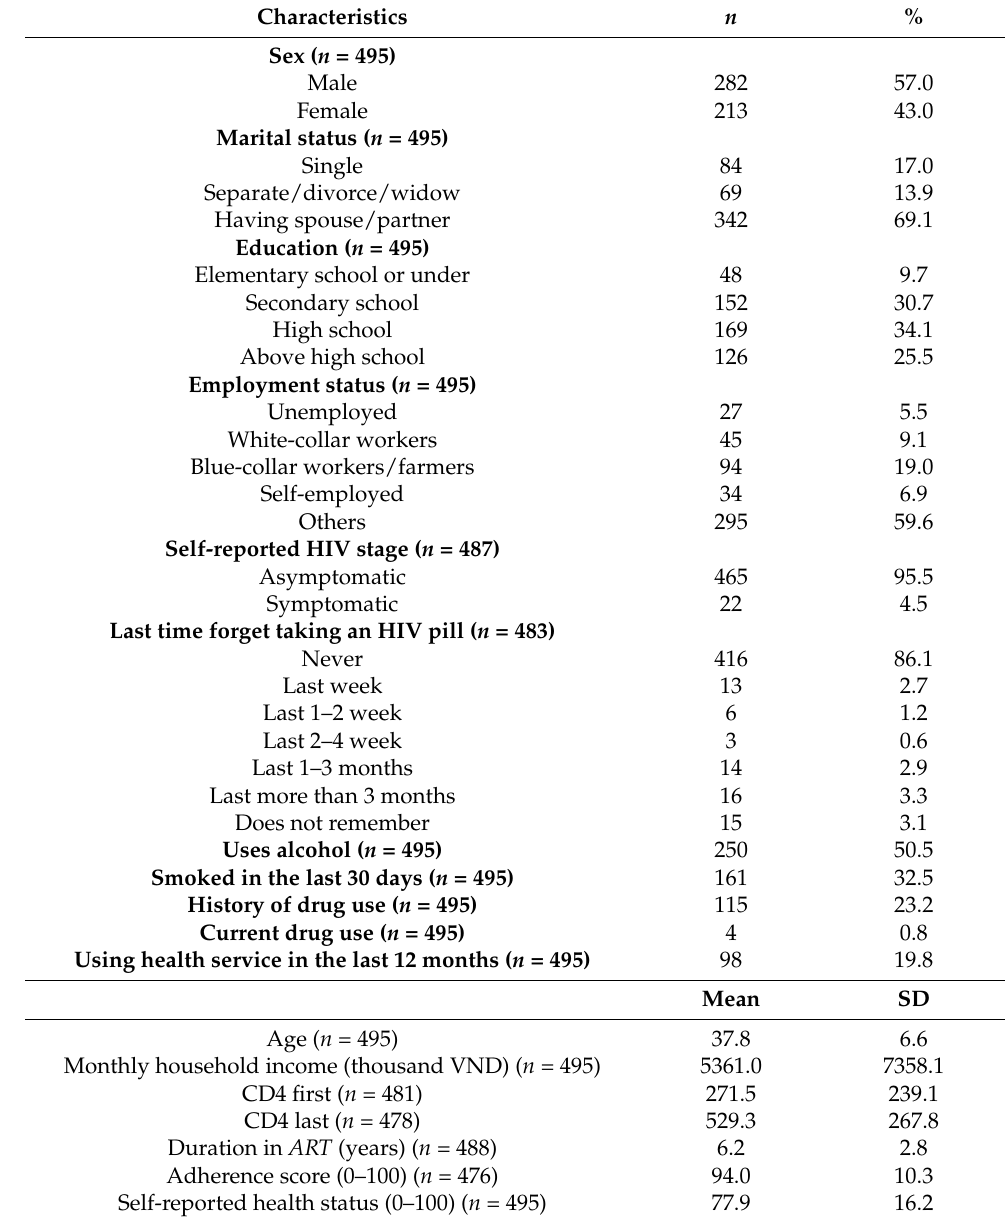
Table 1. Socio-demographic and clinical characteristics.